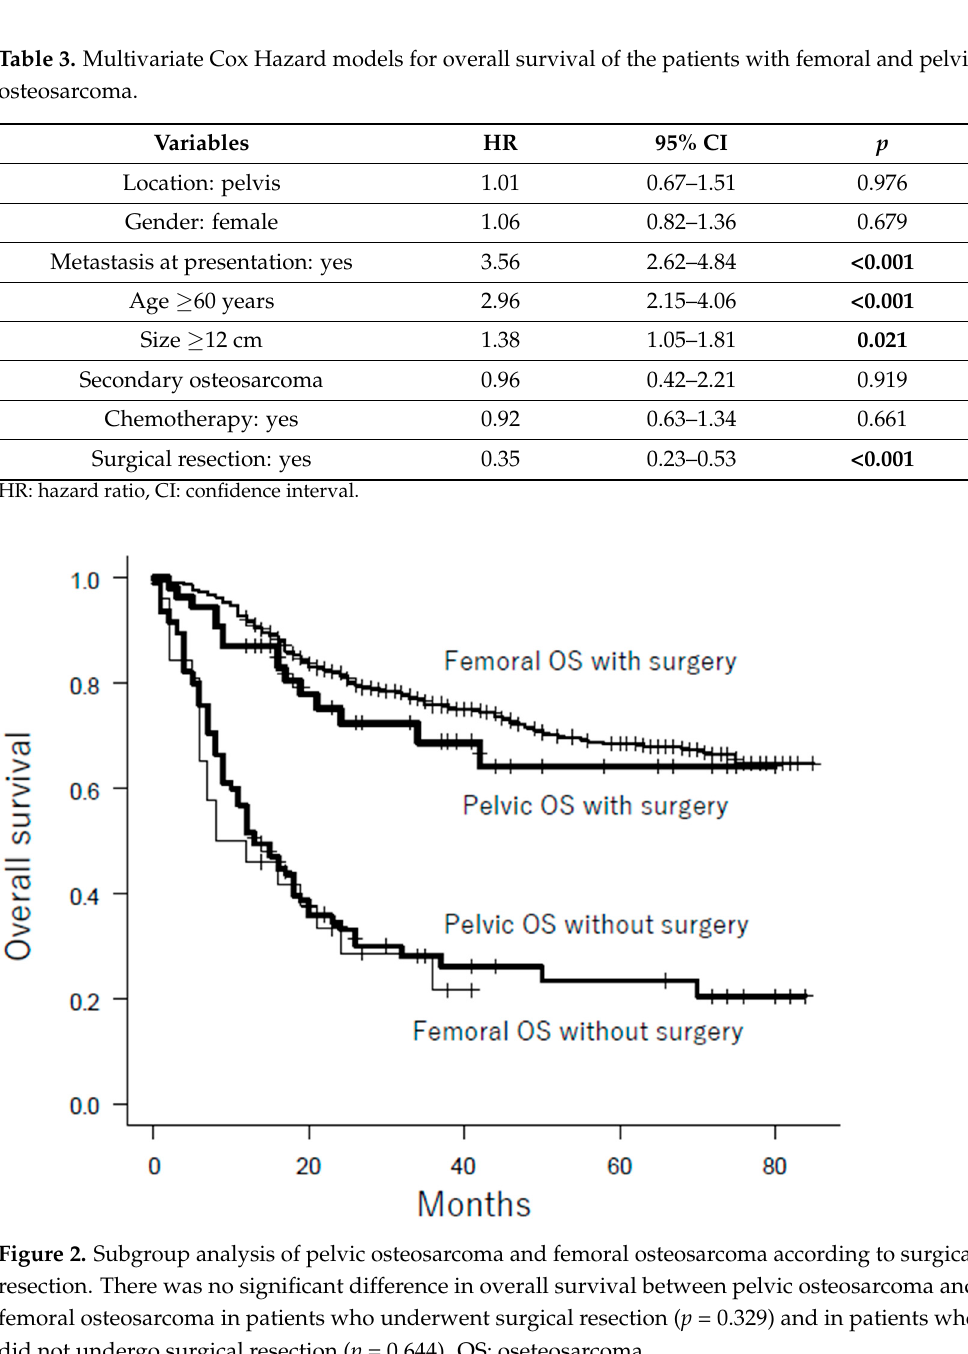
Table 4. Characteristics of the pelvic osteosarcoma treated with or without surgical resection before and after propensity score matching.